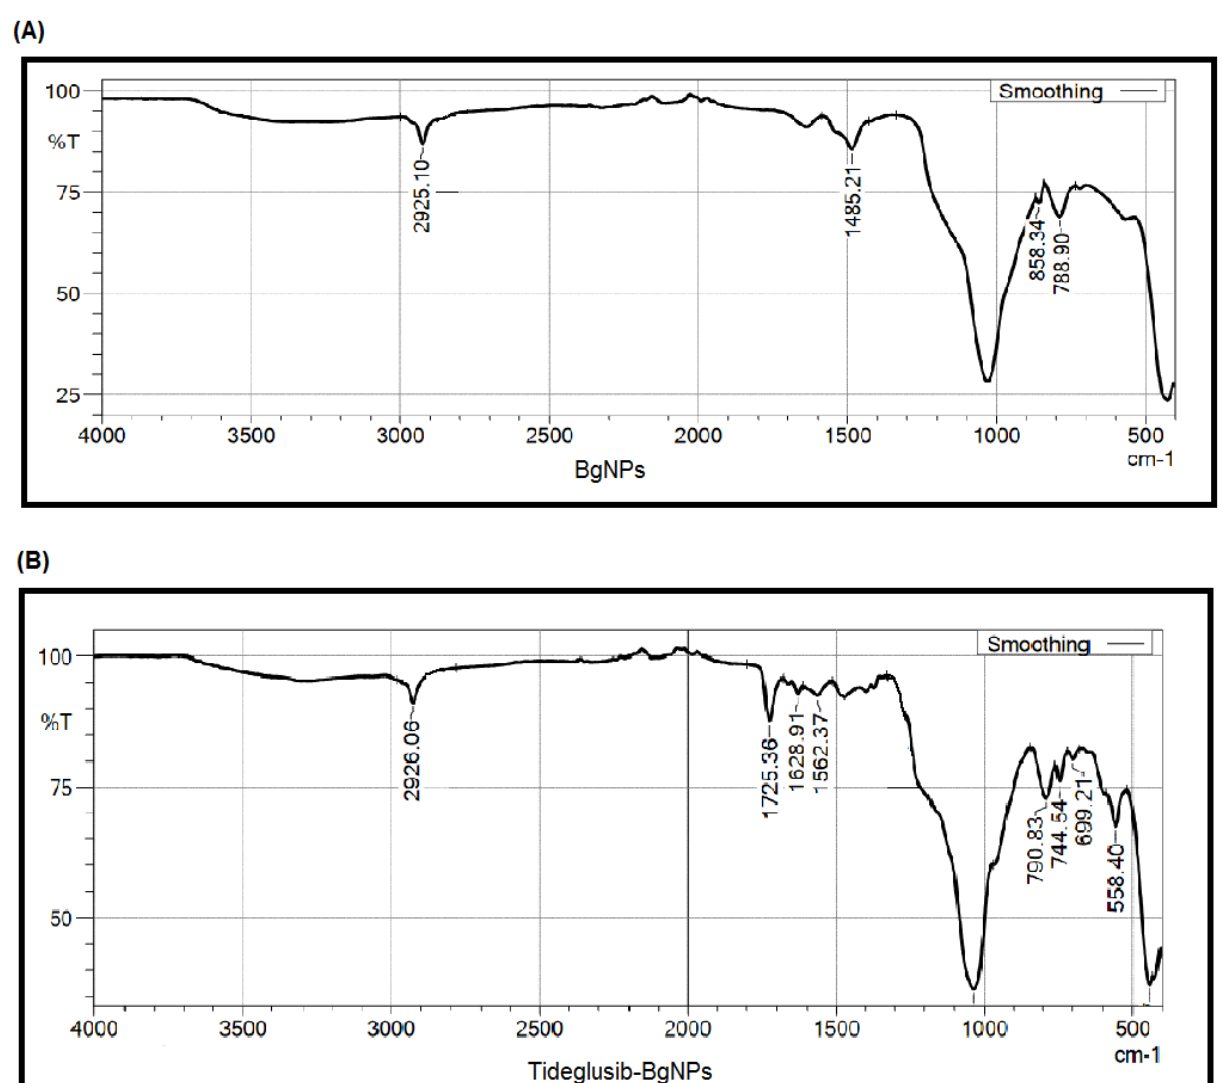
Figure 2. Microstructural behavior of the nanoparticles established using FT-IR ( A ) and XRD ( B ). At 558 and 788 cm − 1 , Si-O-Si asymmetric stretching and vibration were recorded. Water absorption of OH on its surface occurred at 1485 cm − 1 , and OH vibrations were noticed at 2925 cm − 1 [21]. Likewise, in XRD, the peak was dispersive, and there was no sharp peak of diffraction, which demonstrates that the nanoparticles were typically amorphous. Particularly at 2theta, around 24 (degrees), a broad peak was noticed, which represents the typical amorphous structure characteristic of silicate glass as described by Chen et al. [27] (Figure